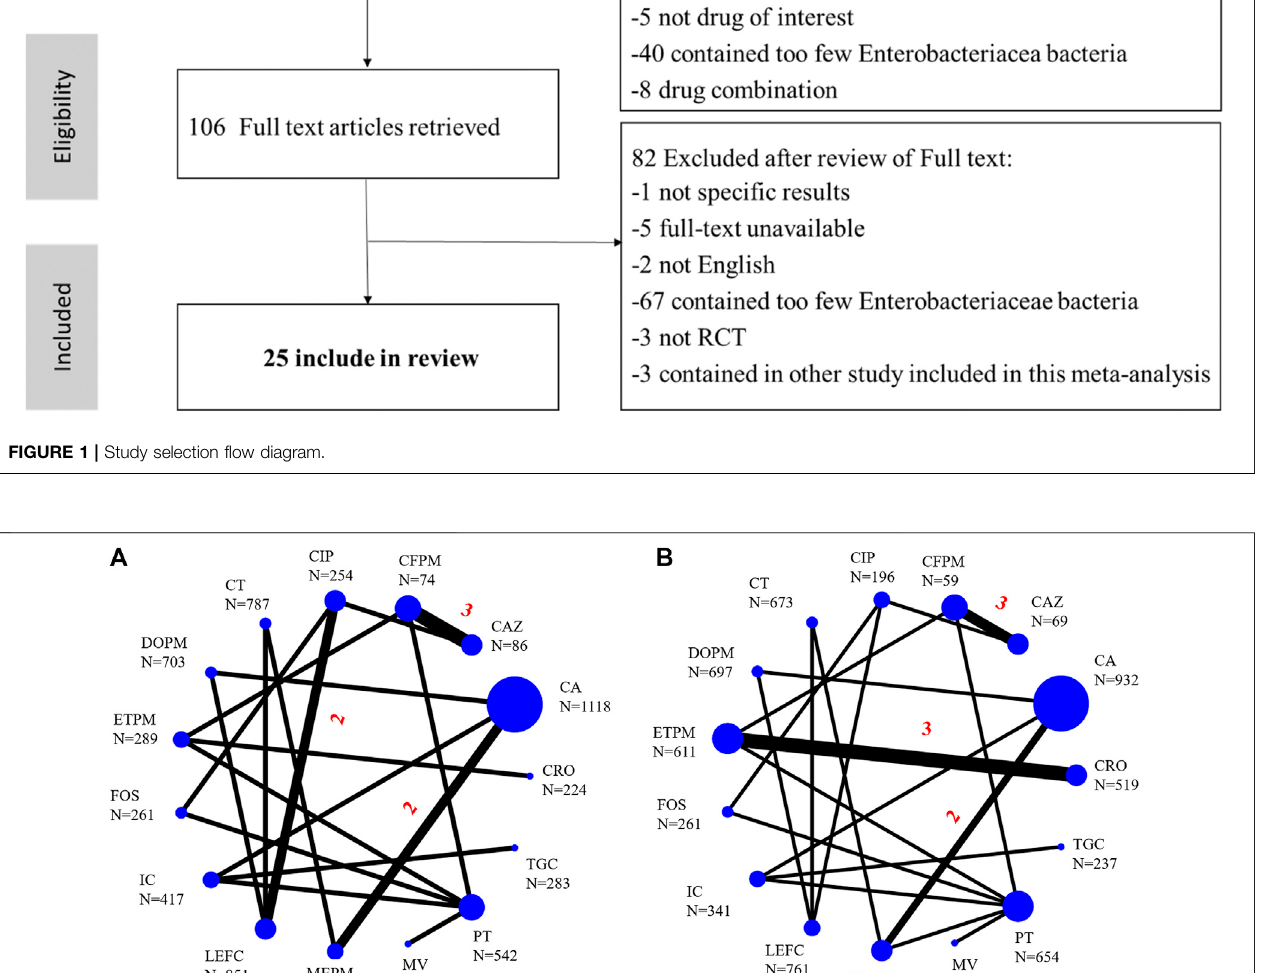
Frontiers in Pharmacology |